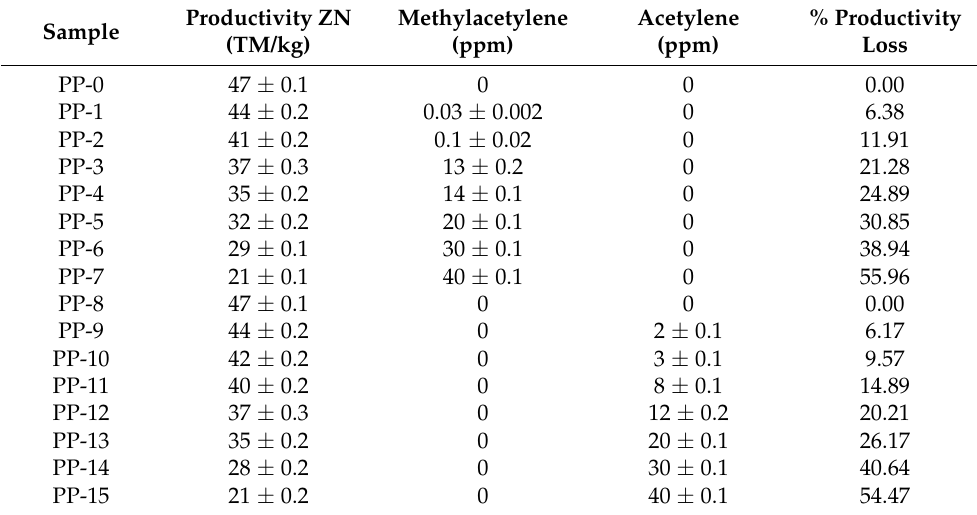
Table 1. Evaluation of the productivity of the polymerization